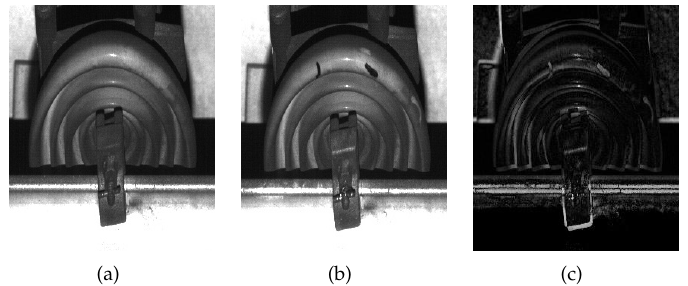
Figure 8. Subtraction result of a pair of facility images: ( a , b ) are facility images which we should compare, and ( c ) their subtraction result. ( a ) was captured in advance before ( b